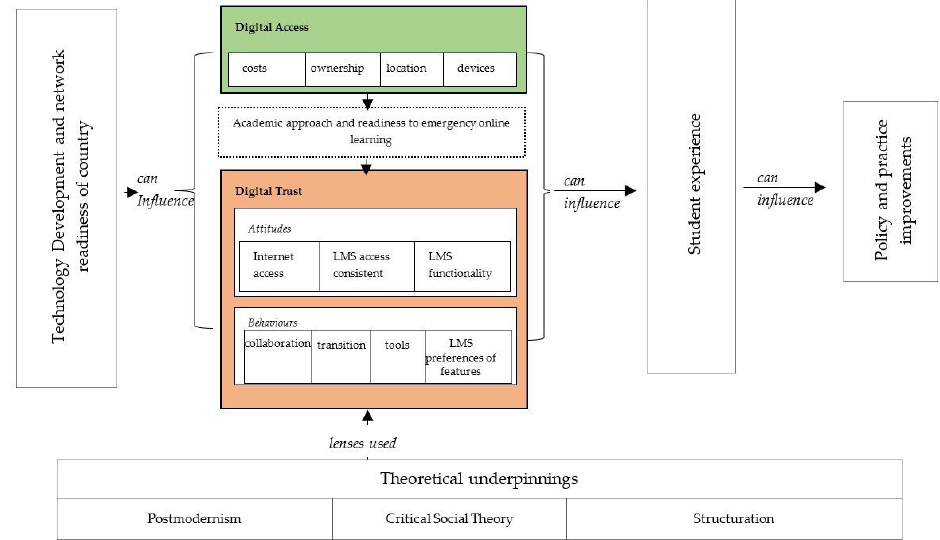
Figure 21. Research study constructs.